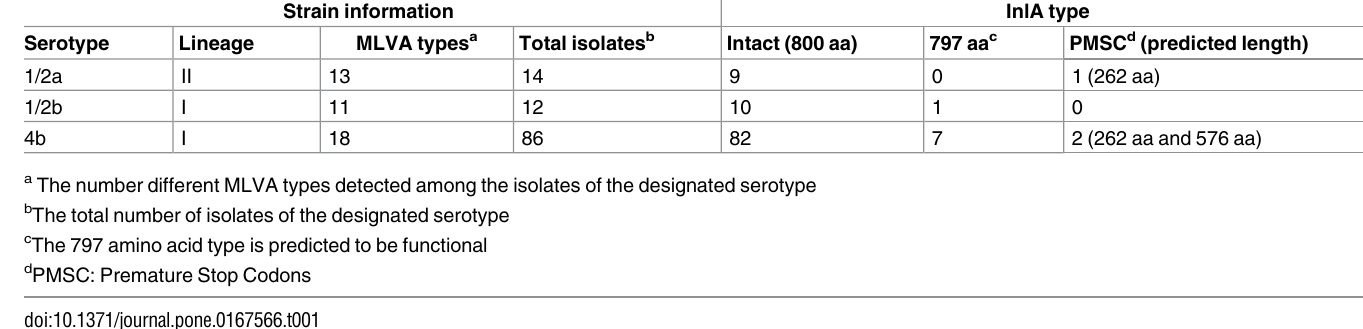
Table 1. Summaryof Predicted InlA lengths among 112 isolates.